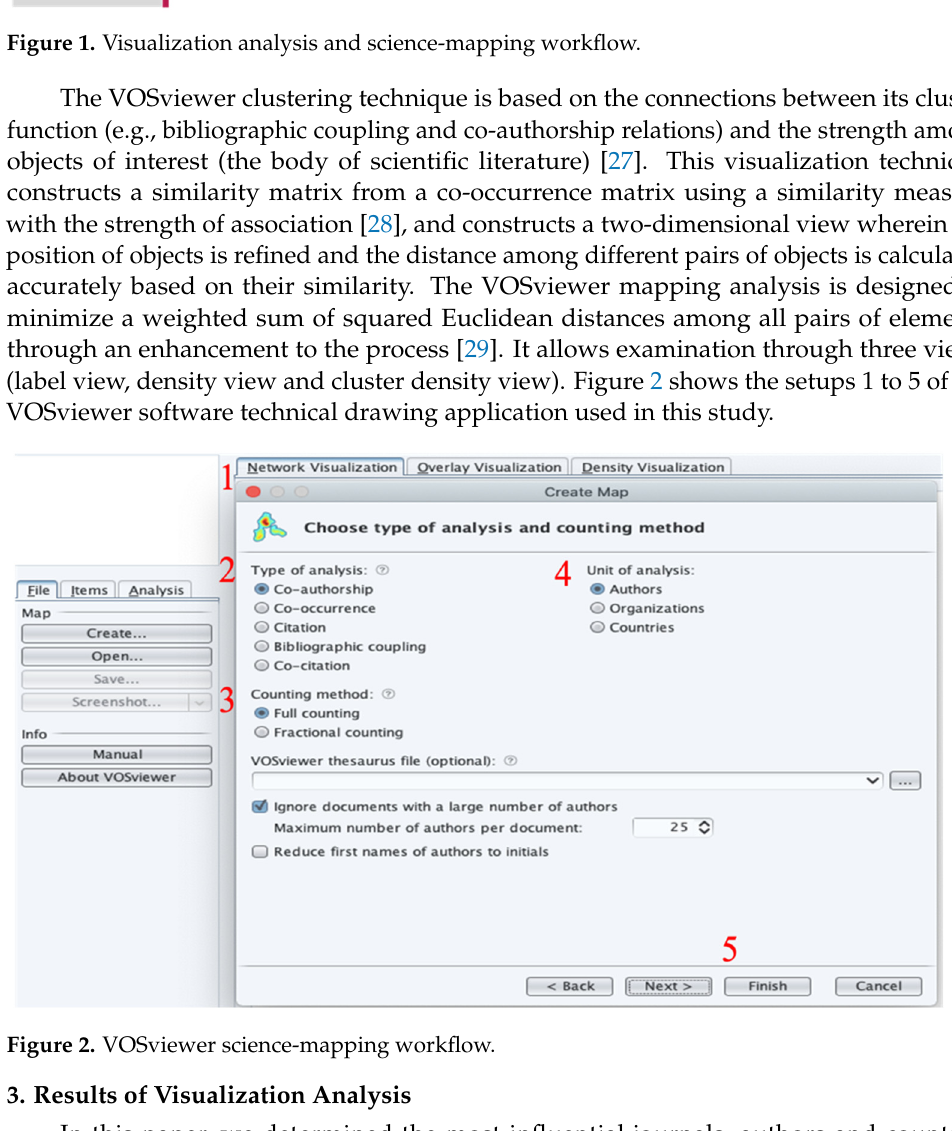
Figure 2. VOSviewer science-mapping workflow.